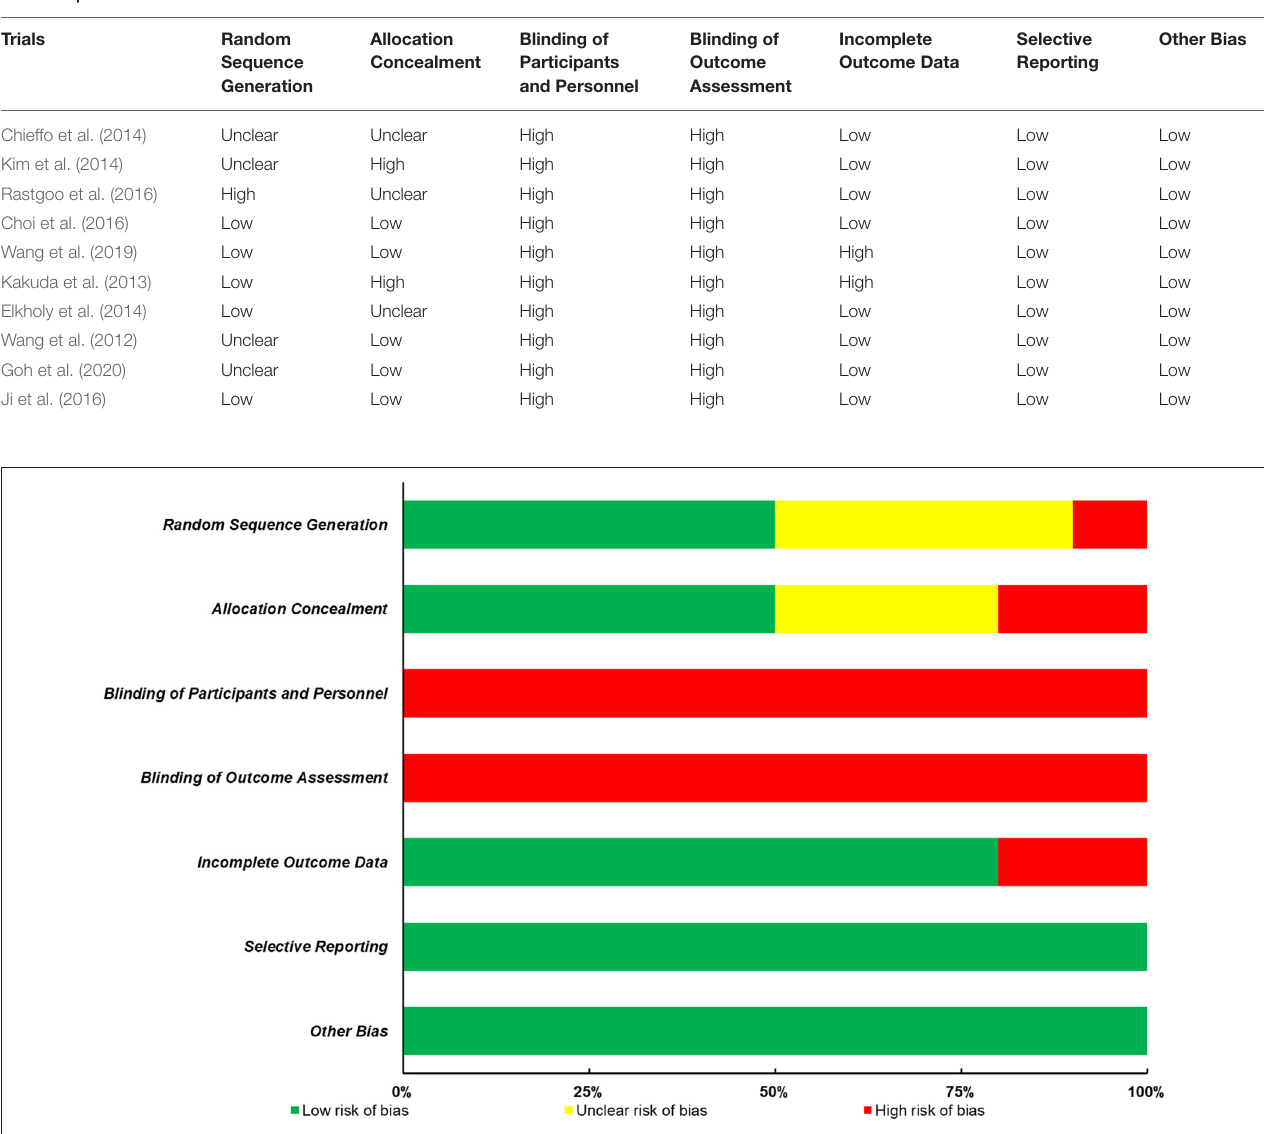
TABLE 1 | Risk of bias evaluation of included